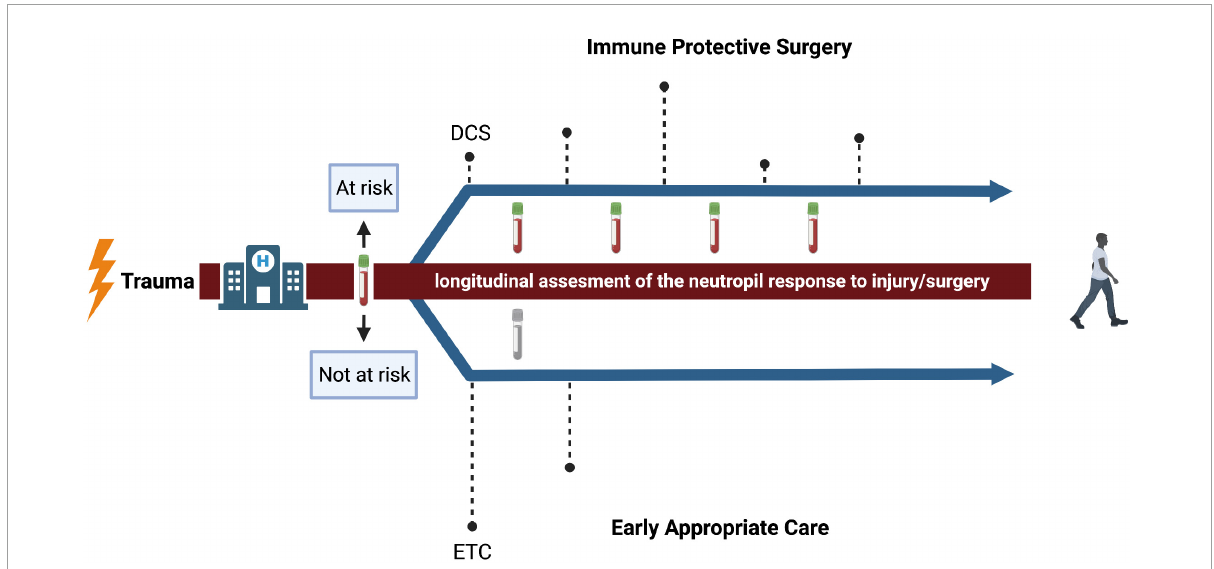
FIGURE2 Conceptual representation of surgical strategies after trauma. The dashed lines represent the timing of surgical interventions and the height of the dashed lines represent the intensity. The upper arrow represents a proposed strategy for patients that, after flow cytometric measurement of the neutrophil compartment, are expected to be at risk for infectious complications. The impact of surgery is minimized and adjusted over time to reassessment of the neutrophil response. The lower arrow represents a proposed strategy for patients that are expected to be not at risk. Here, the approach of early appropriate care is suggested. DCS, damage control surgery; ETC, early total care. Created with